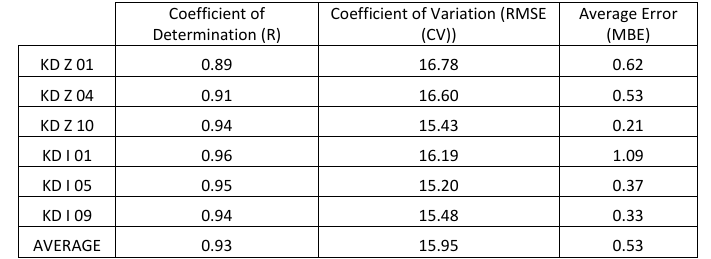
Table 3 Measured and calculated indoor temperature limit values (8760 - hour) of Industrial Engineering Department Lecturer Rooms